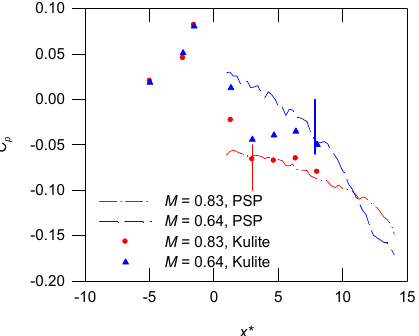
Figure 11. Pressure distribution in the presence of CoV VGs for h* =